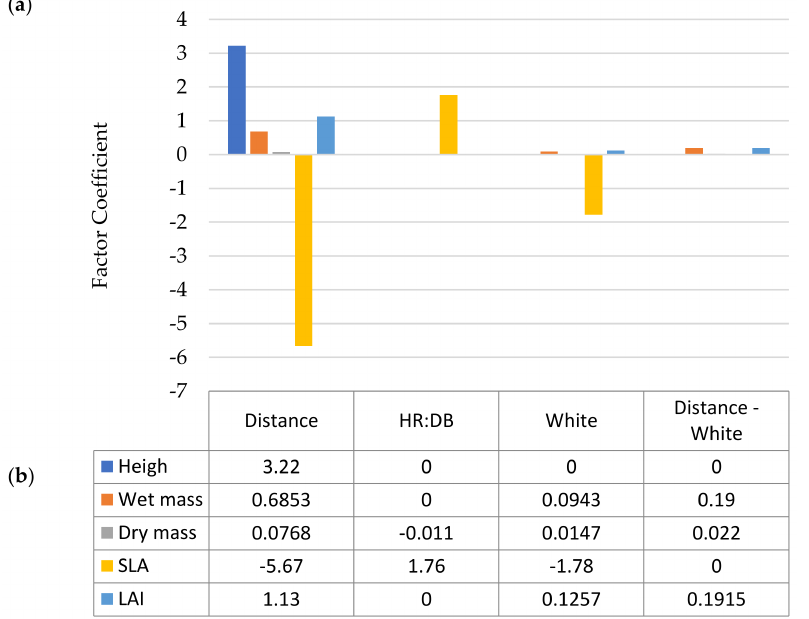
Figure 7. Effects sizes of the most relevant independent variable on several significant responses related to the overall plant. ( a ) Graphical trend and ( b ) numerical coefficients (error bar = 0.05%, too small to be visible on the